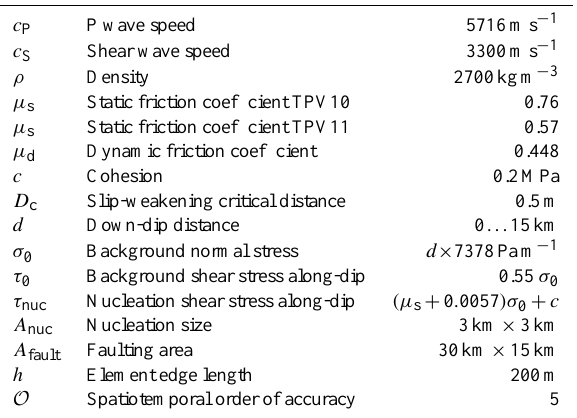
Table 1. Simulation parameters for SCEC test cases TPV10 and